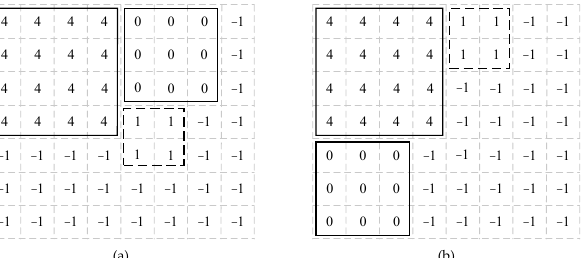
Figure 7. The method of secondary local exploration. ( a ) One of the layouts of chiplet 0 with minimum CEC. ( b ) An alternative layout for chiplet 0 with the same CEC.